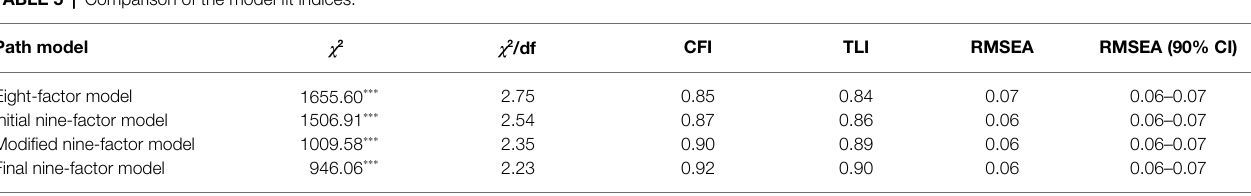
TABLE 5 | Comparison of the model fit